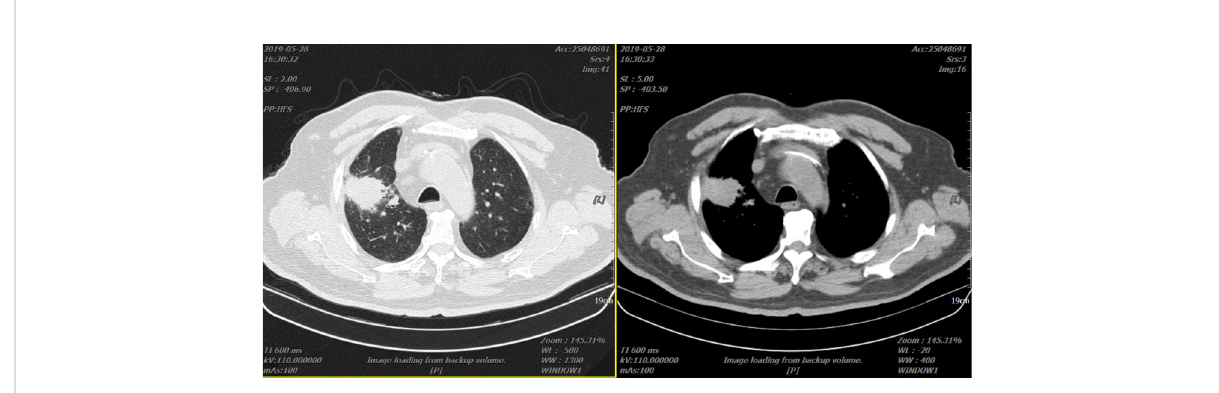
FIGURE 2 Two representative CTs of the patient on 28 May